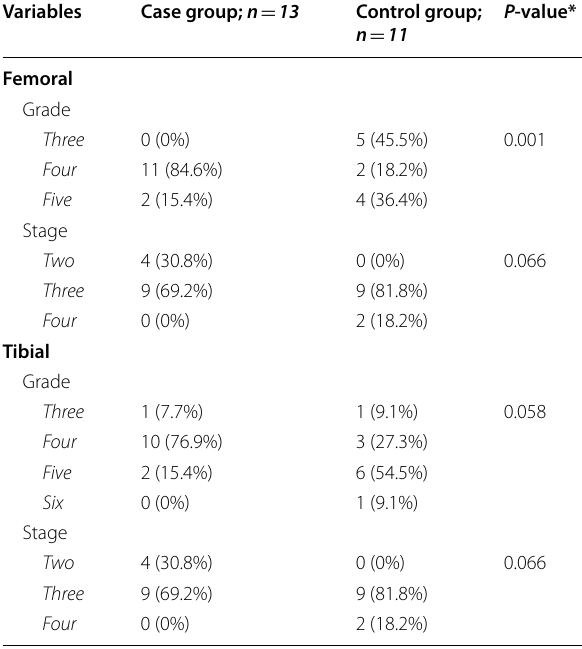
Table 3 Comparison of microscopic findings of subjects treated with captopril (case group) and subjects treated with normal saline (control group) based on osteoarthritis